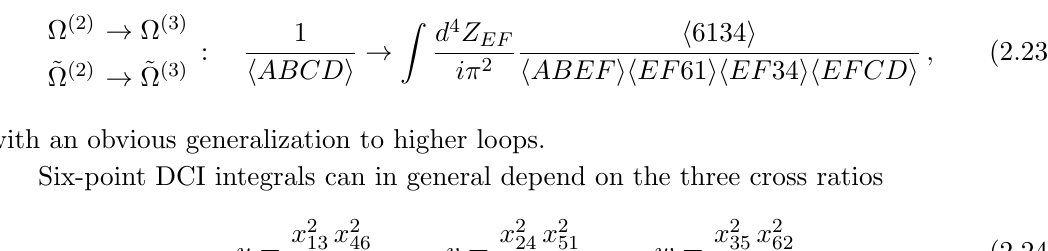
Figure 3 . The six-point integral (cid:10) ( L ) , labelled by dual coordinates, where the ladder is formed out of L (cid:0) 2 loops. The dashed lines represent numerator factors that render the integral DCI. (cid:12)rst class of integrals, (cid:10) ( L ) , is shown in (cid:12)gure 3. The dashed lines in this diagram indicate the numerator factors x (cid:11) _ (cid:11) and x (cid:11) _ (cid:11) , although we could have equivalently chosen x (cid:11) _ (cid:11) and a 1 b 1 a 2 x (cid:11) _ (cid:11) (which, in our convention, would have swapped these dashed lines for wavy lines). The b 2 diagram for ~ (cid:10) ( L ) di(cid:11)ers by the exchange of just one of these numerator factors for its parity conjugate | or, graphically, by the exchange of one of the dashed lines for a wavy line. These pentaladder integrals can be most easily de(cid:12)ned in momentum twistor space, as repeated insertions of a box into (cid:10) (2) and ~(cid:10) (2) . For example, the three loop integrals may be obtained from eqs. (2.9) and (2.10) by the